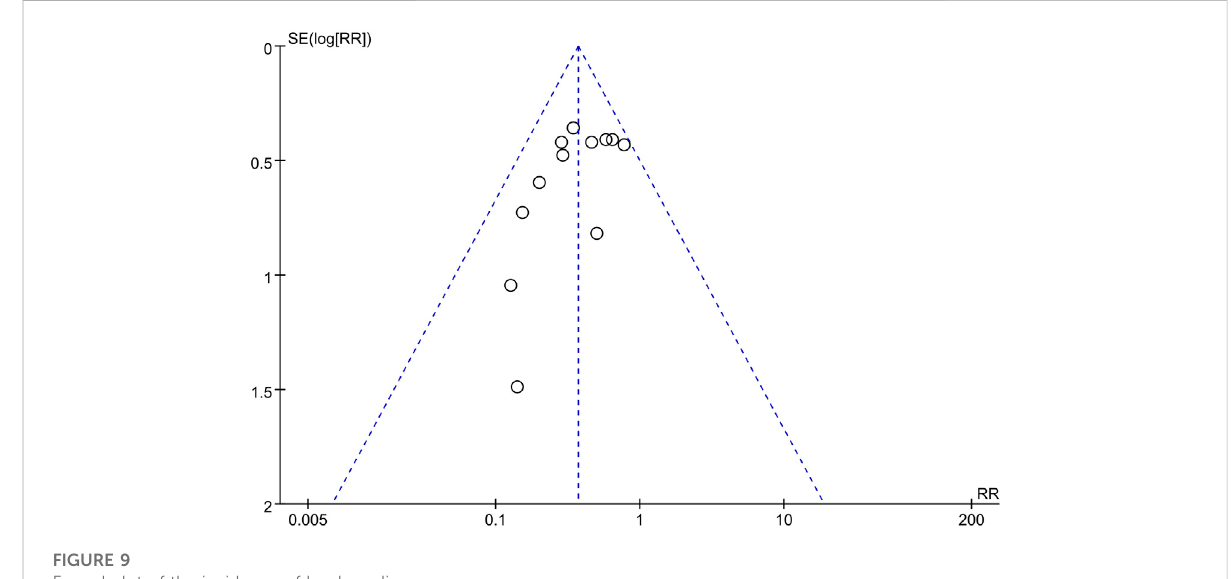
FIGURE 9 Funnel plot of the incidence of bradycardia.